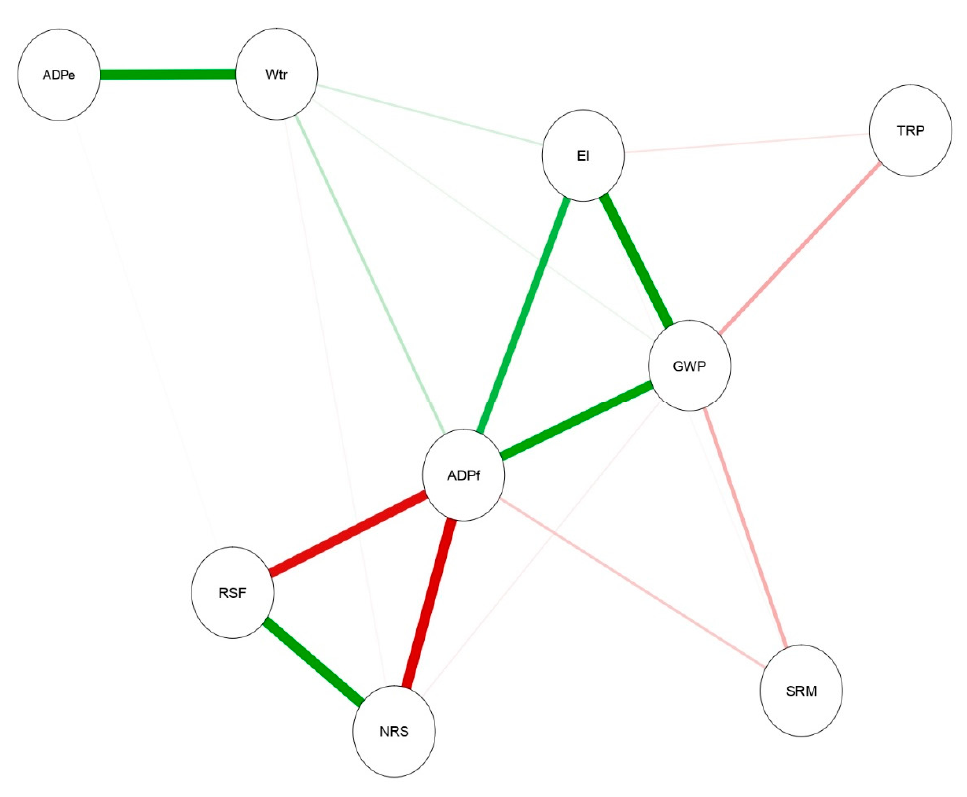
Figure 3. Correlation between GWP and the Consumption ICs.